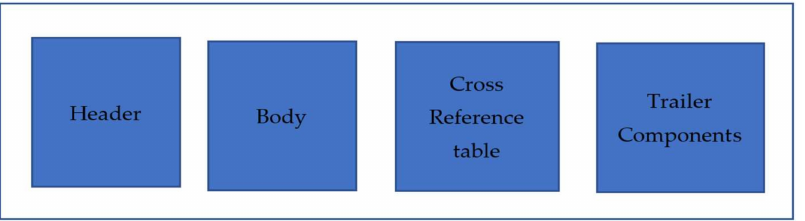
Figure 1. Structure of a PDF file.